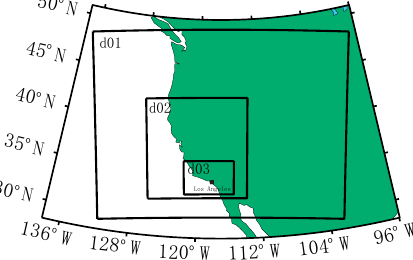
Figure 1. Geographical display of the three-nested model domains. The innermost domain covers the Los Angeles basin; the black point denotes the location of Los Angeles.